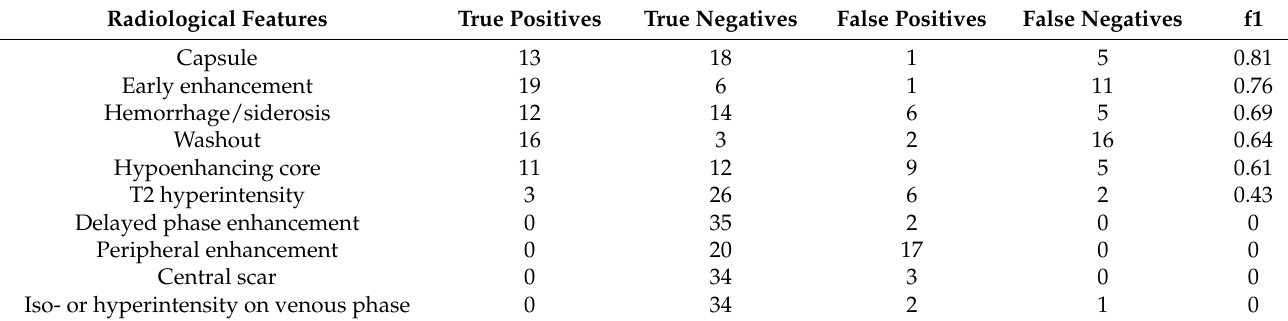
Table 5. Results for annotated features: hepatocellular carcinoma.